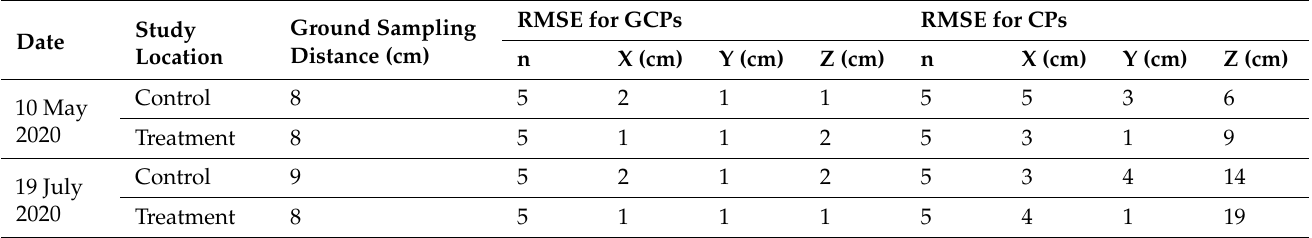
Table 4. Statistics for sUAS multispectral flights: sample size (n) and root mean square error (x, y, and z) in geolocation of multispectral products for ground control points (GCP) and check points (CP).